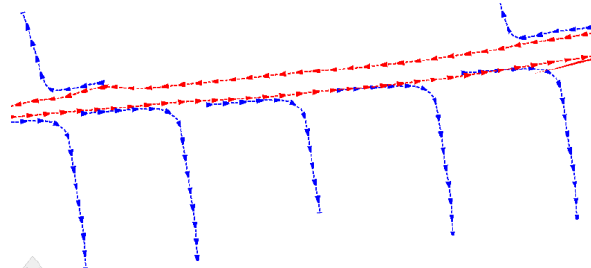
Figure 7. MLS vehicle trajectory (block A – red; block B – blue).